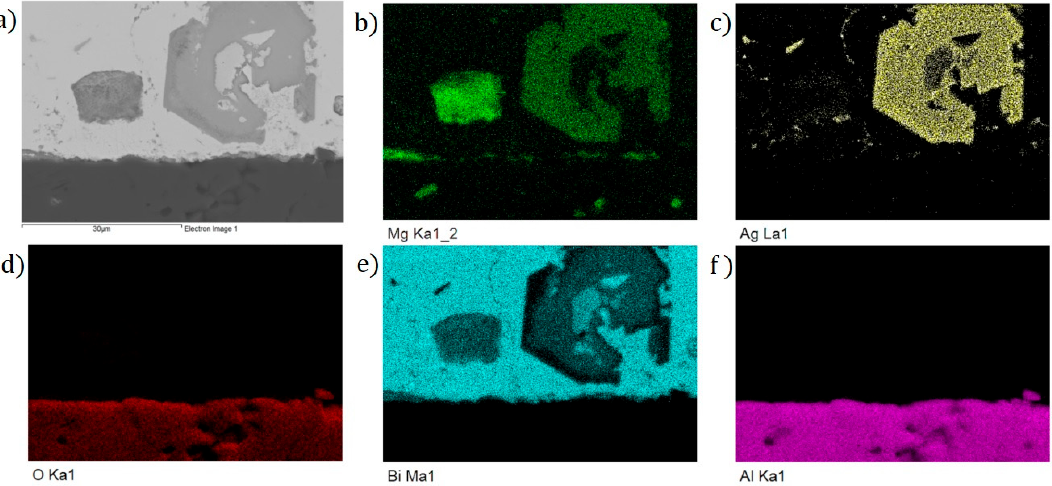
Figure 15. Planar distribution of elements on Al 2 O 3 /Bi11Ag1Mg joint boundaries: ( a ) joint microstructure; ( b ) Mg; ( c ) Ag; ( d ) Bi; ( e ) Al; and ( f ) O.